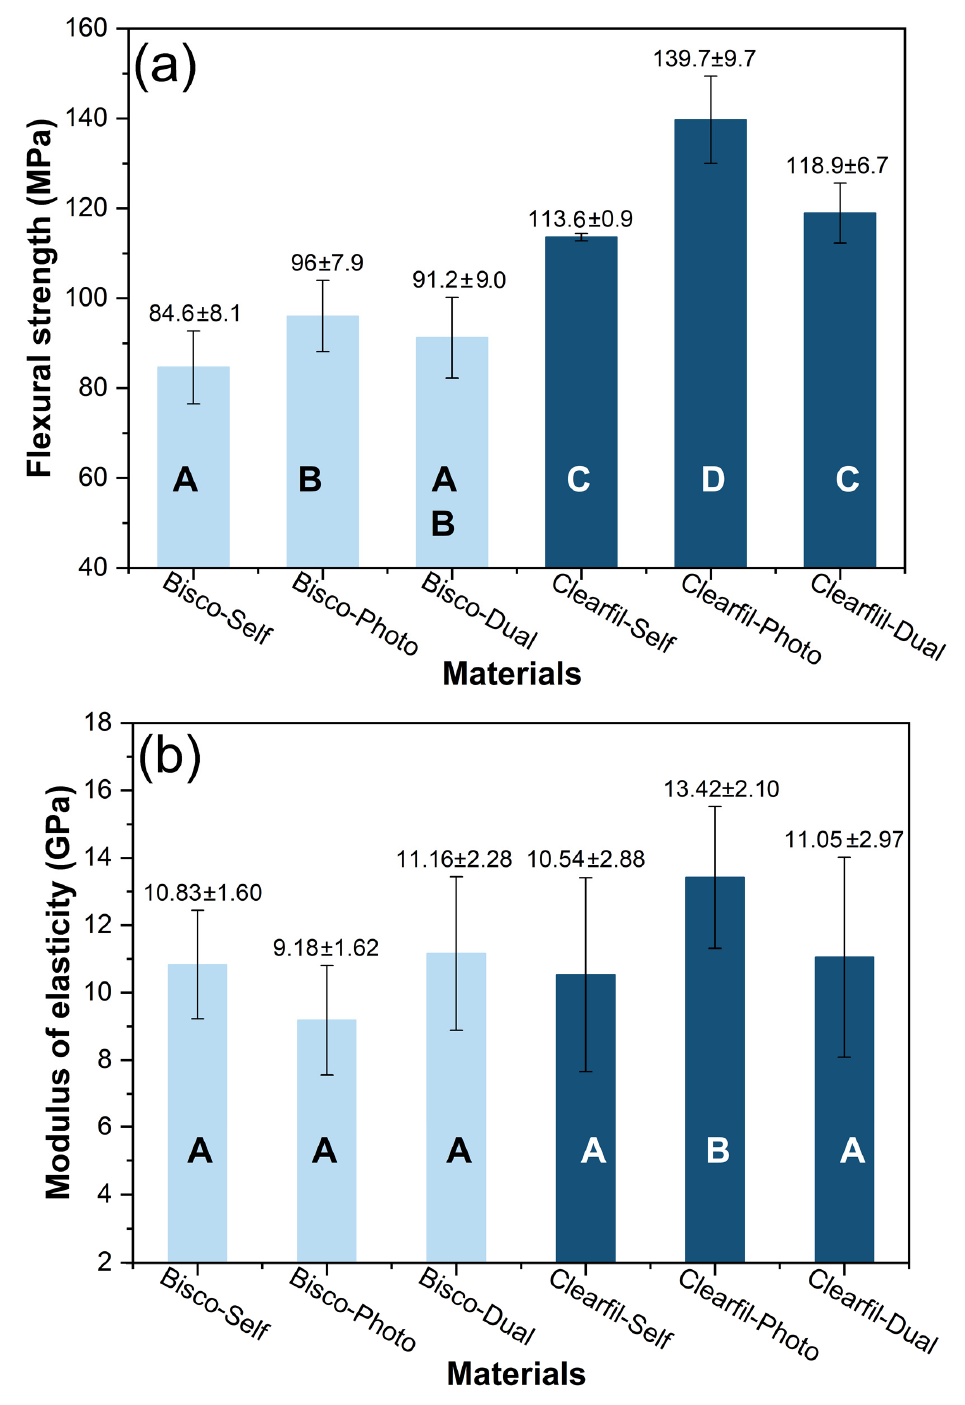
Figure 3. Mean and standard deviation values of ( a ) flexural strength and ( b ) modulus of elasticity of core composites. The same letters indicate no significant difference between materials ( p >